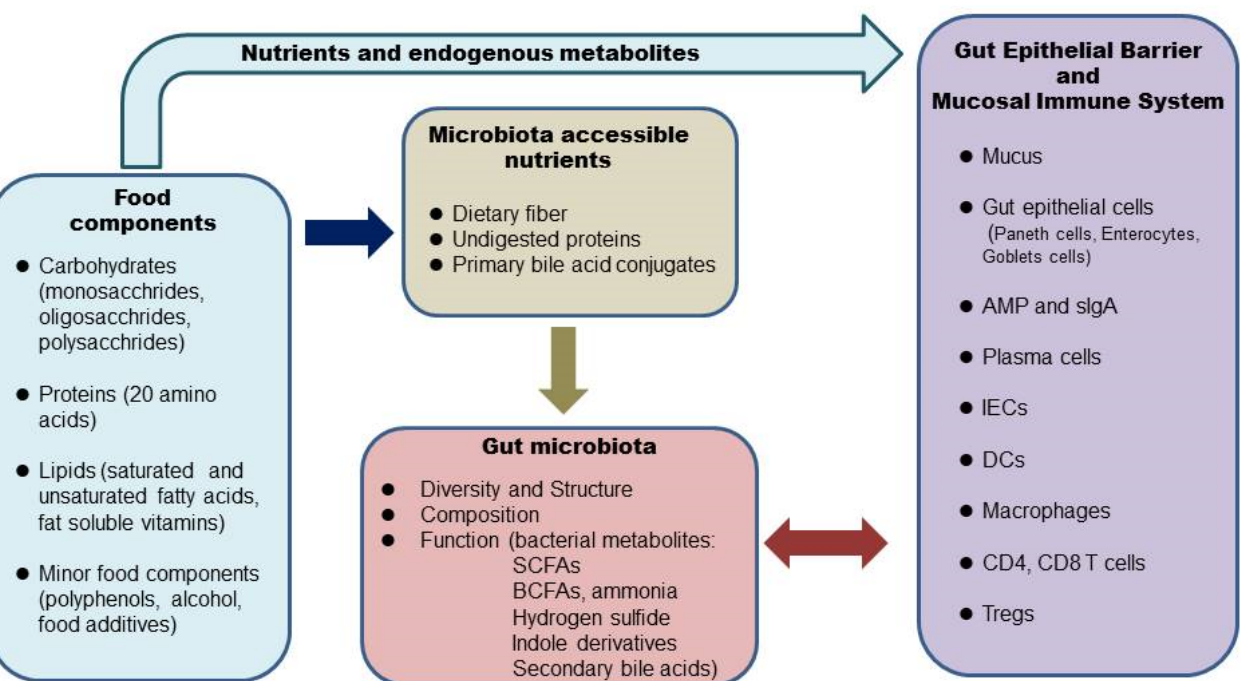
Figure 1. Impacts of foods and nutrition on the microbiota-host interactions in the gut. The arrow indicates regulation. Food components and endogenous metabolites of nutrients directly modulate the gut epithelial barrier and mucosal immune system. Diet also determines microbiota-accessible nutrients, which play a critical role in the gut microbiota ecology. The interaction between the gut microbiota with host epithelium and the mucosal immune system determines intestinal homeostasis. IEC, intraepithelial lymphocytes; AMP, antimicrobial peptides; sIgA, secretory immunoglobulin A; DCs, dendritic cells; SCFAs, short-chain fatty acids; BCFAs, branched-chain fatty acids.